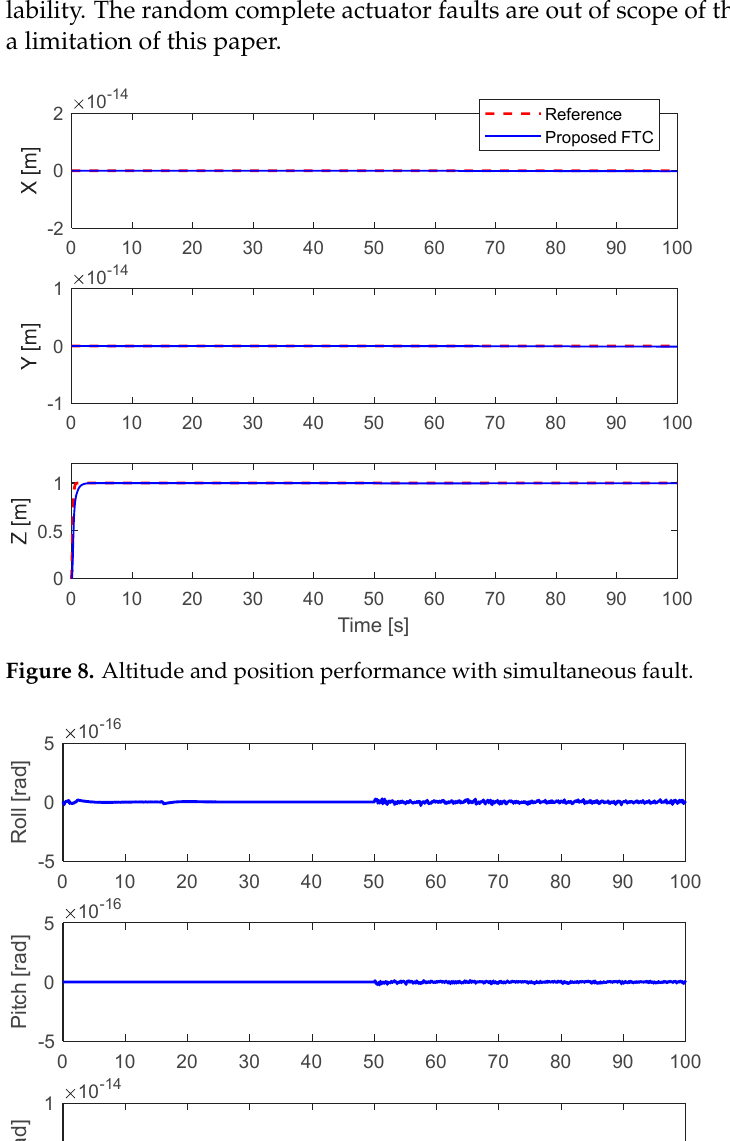
Figure 7. Response of motor’s command with complete fault in actuator 1 and partial fault in actu- ator 2.